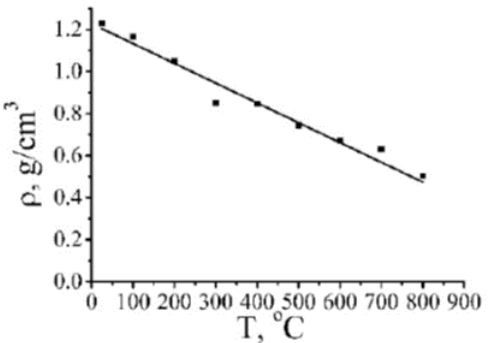
Figure 6. Dependence of the density of partially reduced GO on the annealing temperature [63,64].